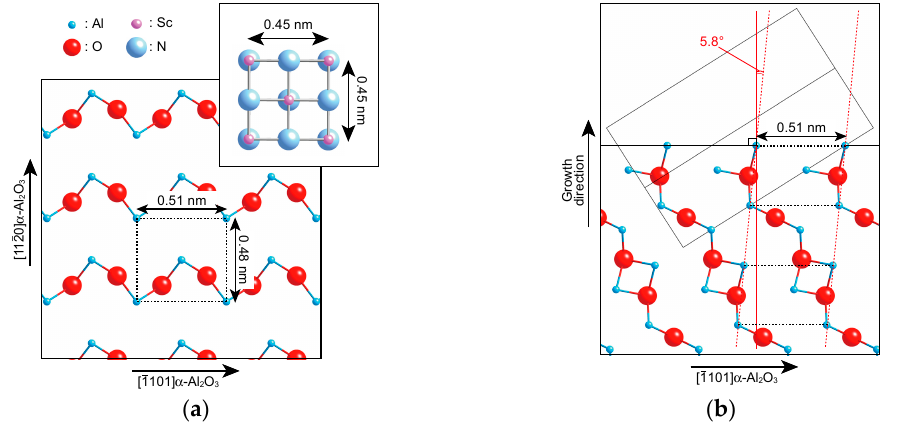
Figure 3. Atomic arrangements of the α -Al 2 O 3 (11 (cid:3364) 02) substrate and the ScN film: ( a ) α -Al 2 O 3 (11 (cid:3364) 02) and ScN(100) surfaces and ( b ) cross-section of α -Al 2 O 3 (11 (cid:3364) 02). The rectangle in ( b ) indicates the unit cell of α -Al 2 O 3 .